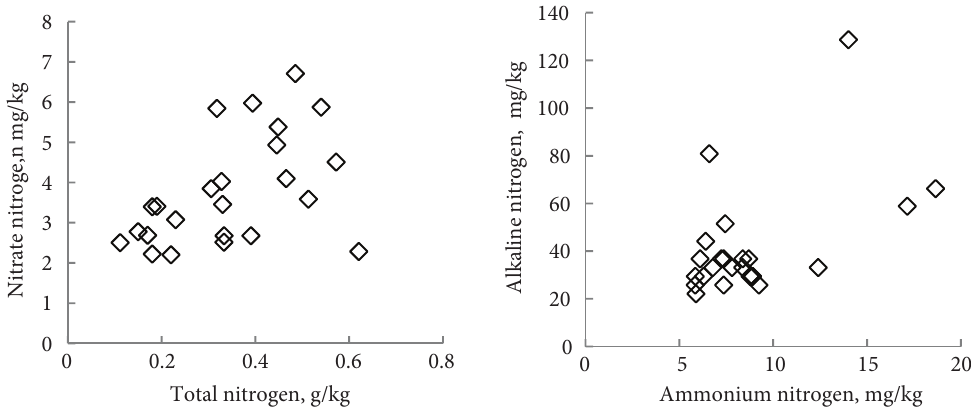
Figure 5. The relationships between different forms of soil nitrogen in the loess